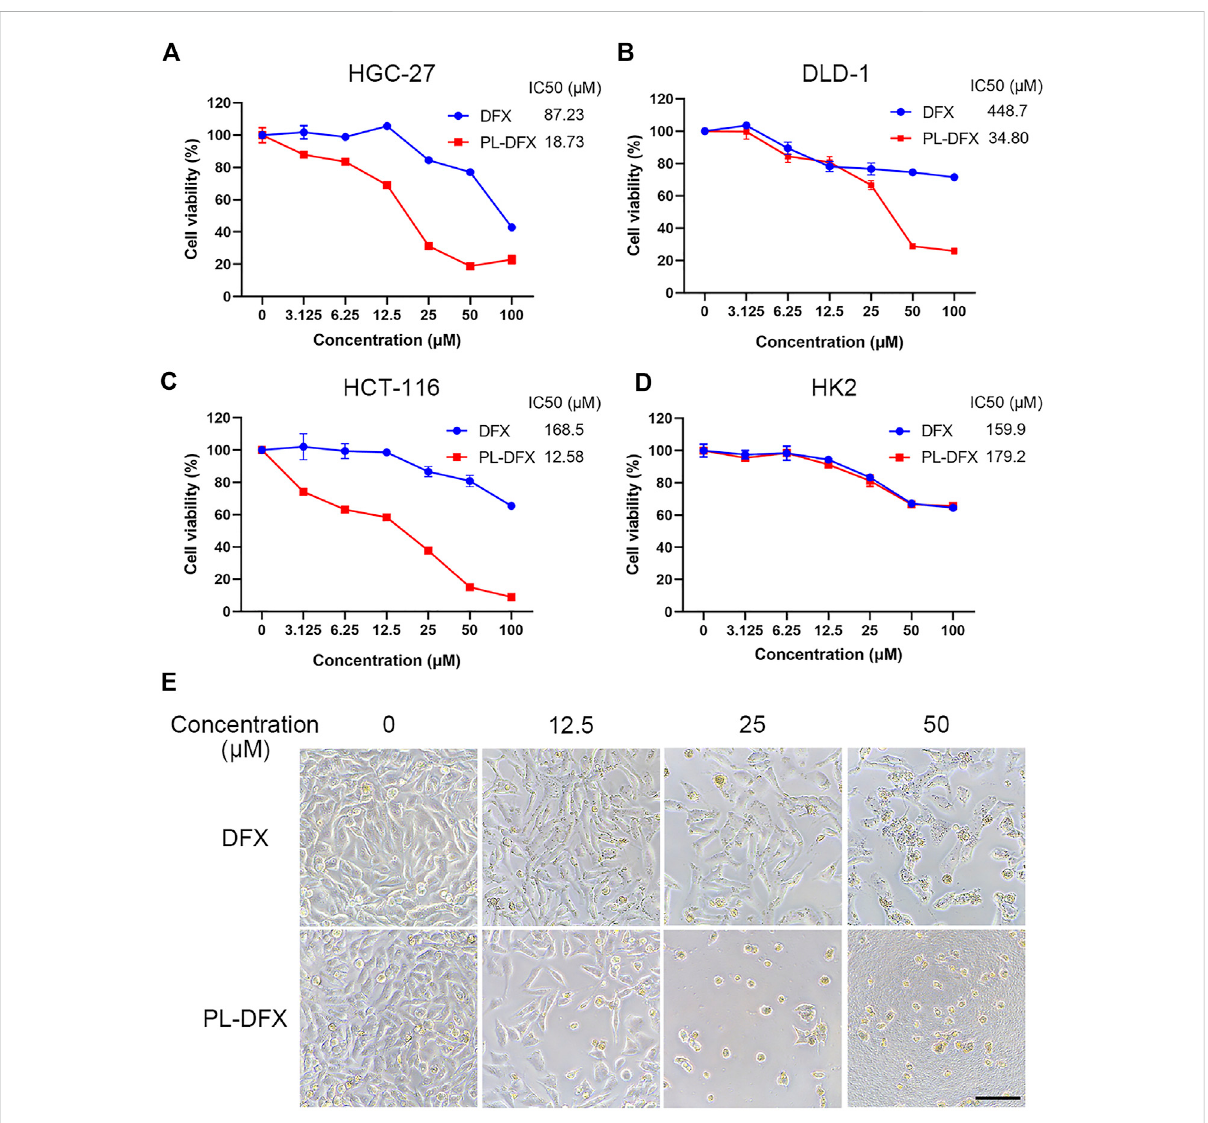
Cytotoxicity of PL-DFX in vitro . (A – C) Cell viabilities of HGC-27, DLD-1, and HCT-116 after incubated with DFX and PL-DFX for 48 h was measuredbyCCK8. (D) CellviabilitiesofHK2afterincubatedwithDFXandPL-DFXfor24 hwasmeasuredbyCCK8. (E) MicroscopicimagesofHGC- 27 after incubated with DFX and PL-DFX for 48 h. Scale bar = 100 μ